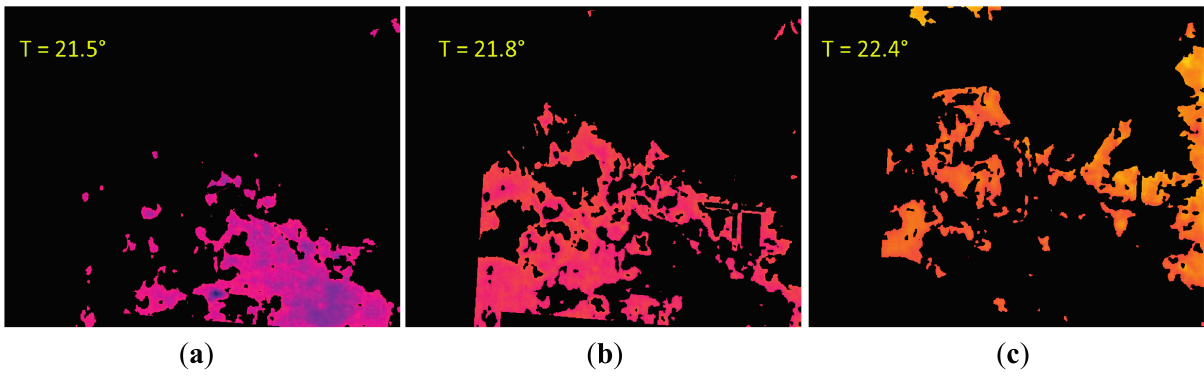
Figure 19. ( a ) Classification map; ( b ) Mask generated from the classification map.